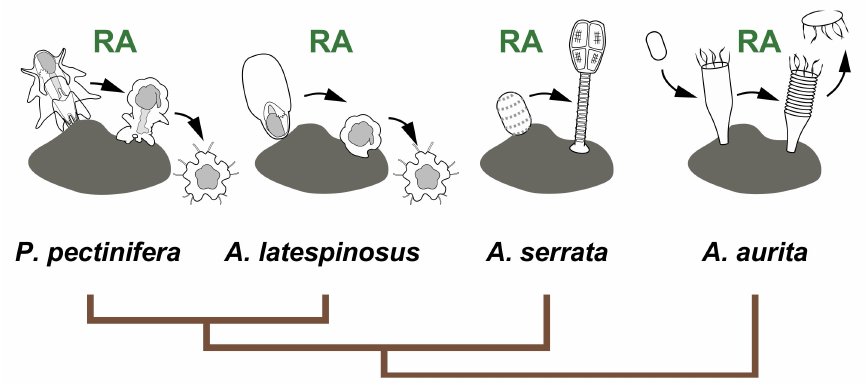
Figure 9. The function of RA signaling in life cycle transition of echinoderms and cnidarians. The involvement of RA signaling in metamorphosis is reported in the starfish P. pectinifera [9], A. latespinosus [10] and the feather star A. serrata [11]. RA is also known as the regulator of strobilation in the jellyfish Aurelia aurita